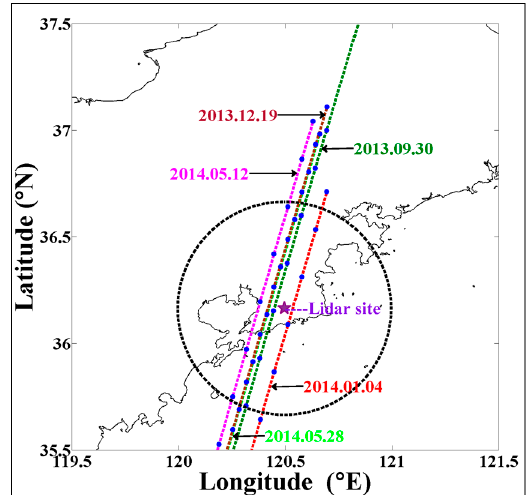
Figure 6. The track of the CALIOP and the site of the WACAL during the simultaneous measurements. The colored lines indicate the footprints of CALIOP and the purple star denotes the WACAL site. The blue solid dots indicate the footprint of CALIOP and CALIOP provides one product profile every dot. The black dashed circle represents a 50-km radius area which is centered on WACAL. Note that the tracks of CALIOP on 19 December 2013 (purple) and 28 May 2014 (green) overlapped each other. The particle depolarization ratios are at 532 nm and the CALIOP measurement data are downloaded from the Atmospheric Science Data Center, NASA.